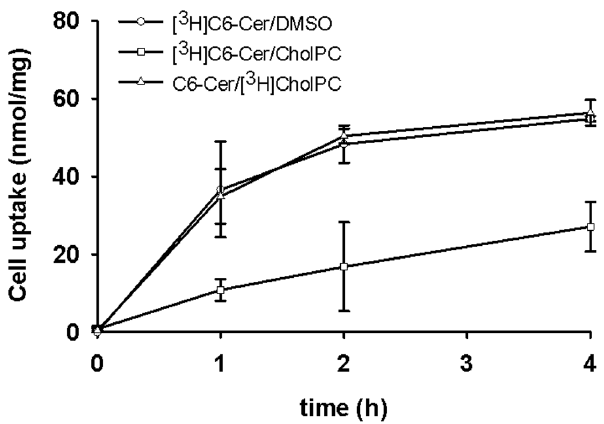
Figure 2. Cellular incorporation of [ 3 H]C6-Cer or [ 3 H]CholPC. FRTL-5 cells were exposed for the indicated time to 0.05 mM of